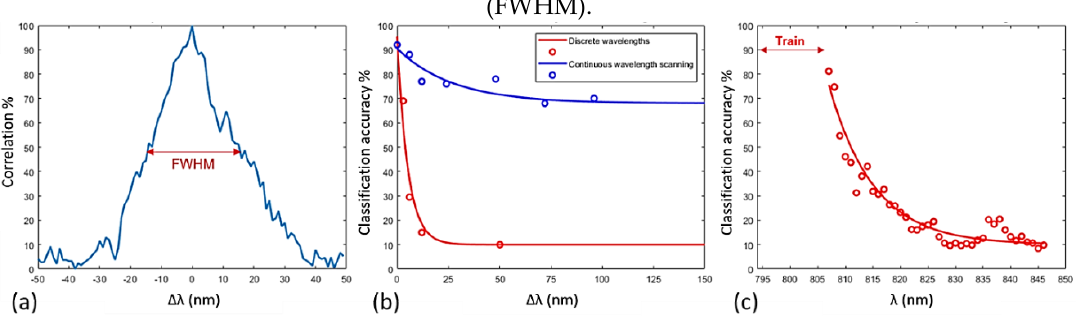
Figure 5. ( a ) Speckle intensity correlation as a function of wavelength drift bandwidth; ( b ) Classification accuracy for datasets collected for the two cases discussed in the text: DNN trained at 800 nm wavelength and tested at data collected at different wavelengths (red circles) and DNN trained with data that include the perturbation (blue circles); ( c ) Classification accuracy for a DNN trained in the presence of 12 nm bandwidth drift and tested at data collected outside this range. All the results are obtained through the same GRIN fiber (10 cm, GIF625, Thorlabs GmbH, Germany).